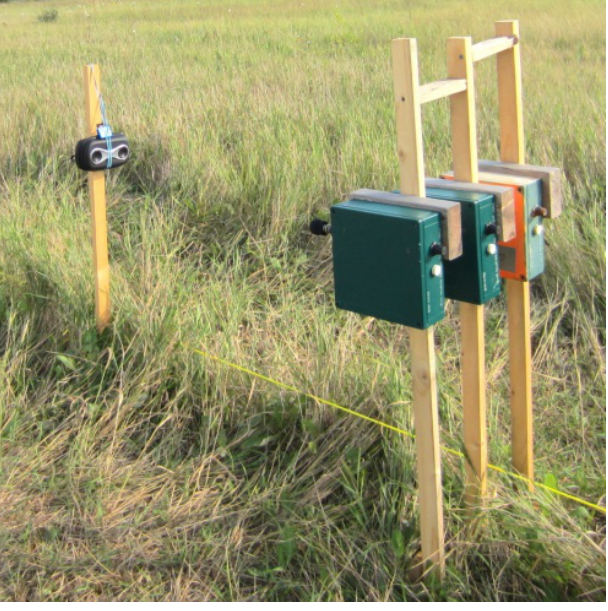
Fig. 2 . Experimental setup showing one of 12 triads of autonomous recoding units used to evaluate the effect of microphone sensitivity loss on detection of calls. We simulated wind noise by broadcasting 42 dBA and 50 dBA (measured 1 m away) of white noise from a pair of speakers placed in front of each triad.